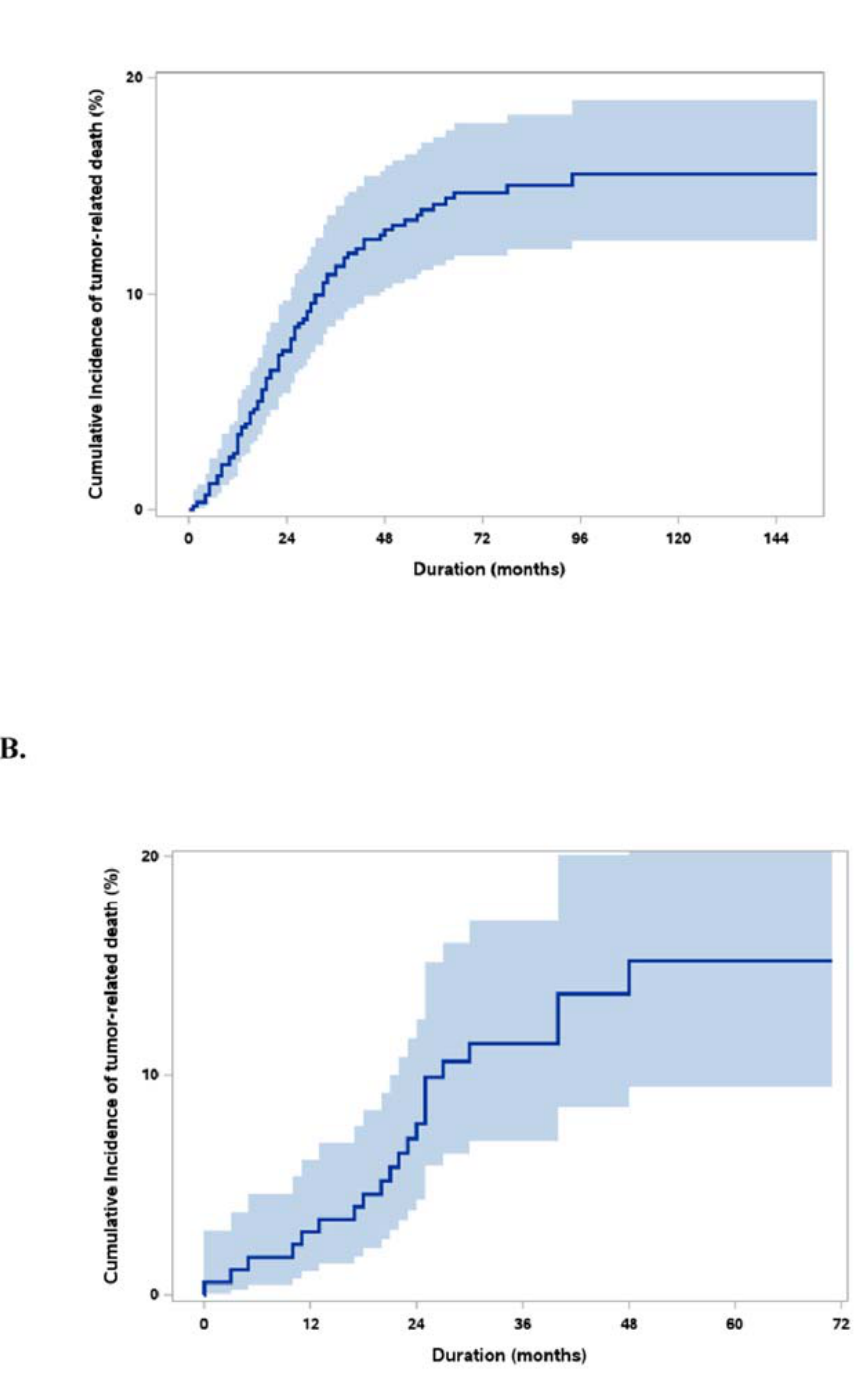
Figure 1. Cumulative incidence curve of HCCDs (95% CI). ( A ). Derivation set. ( B ). Validation set. Table 1. Demographic data of the derivation and validation set.